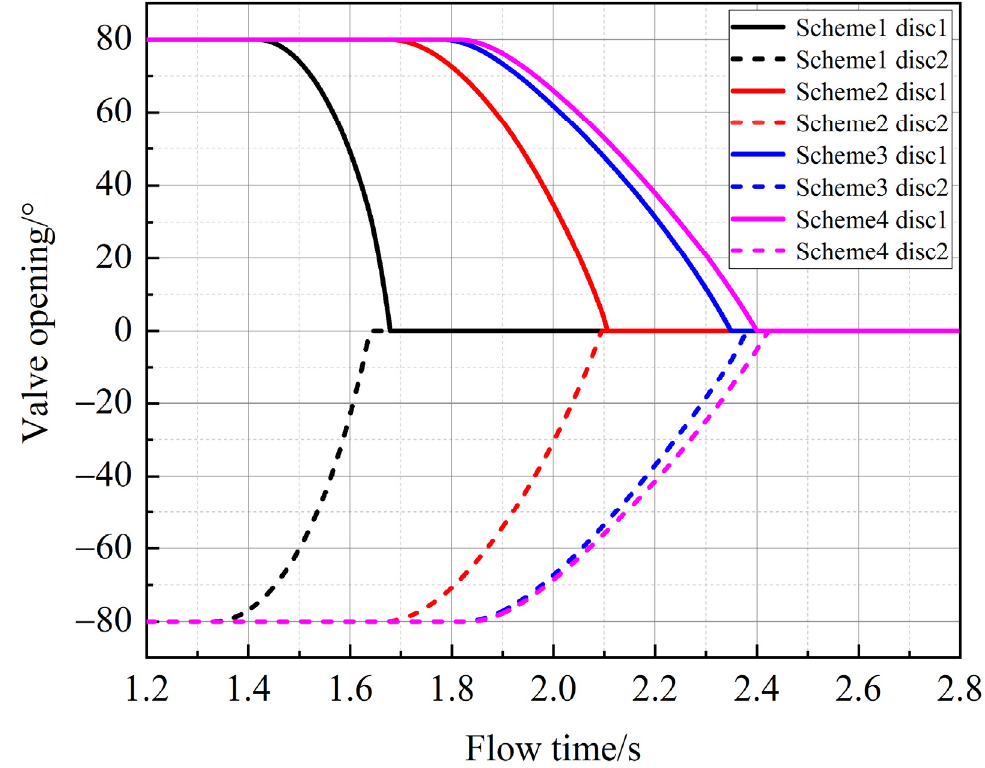
Figure 13. The transient closing curve of the dual disc check valve. That is because when the downstream pressure gradually increases, the flow is blocked, forming a complex vortex and reverse flow, resulting in asymmetric flow distribution downstream. The hydrodynamics acting on the back of the two discs changes non- uniformly but is almost equivalent, so the discs are asynchronously closed, and their clos- ing times are nearly the same. As the downstream pressure gradually increases, the tor- ques acted on the discs become higher, and the discs continue to accelerate to close.